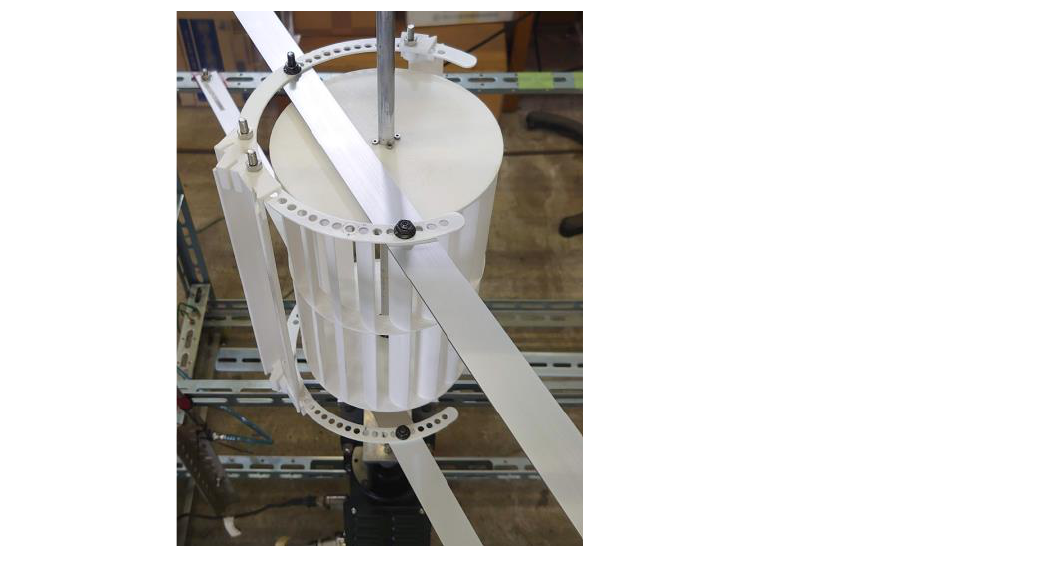
Figure 6. Setting appearance of a cross-flow wind turbine test model with three flow deflectors. For the output performance test, as shown in Table 1, the wind speed at the inlet of the wind turbine was set to 6 m/s, the rotor speed was reduced in steps from a near no-load rotation speed to 0 rpm, and the torque and rotation measurements were measured at each step. As shown in Figures 2 and 3, the dimensions of the wind turbine test model for this study were small; that is, because this output performance test was conducted on a small scale, the measured data were easily affected by the setting at the time. For this reason, measurements for all conditions listed in Table 1 were conducted together at one time (in one day). Each condition was measured three times, and the average of these measurements was obtained. For reference, Figure 7 shows the result of the output performance test for the bare cross-flow wind turbine with no flow deflector shown in Figure 2 obtained by eight measurements from 2020 to 2021. The vertical axis is the power coefficient and the horizontal axis is the tip speed ratio. The averaged output performance curve of eight measurements with standard deviation bars was compared with the output performance curve obtained from the measurement for this study. There was a slight difference between these curves near the peak points but except there, these curves were nearly coincident.